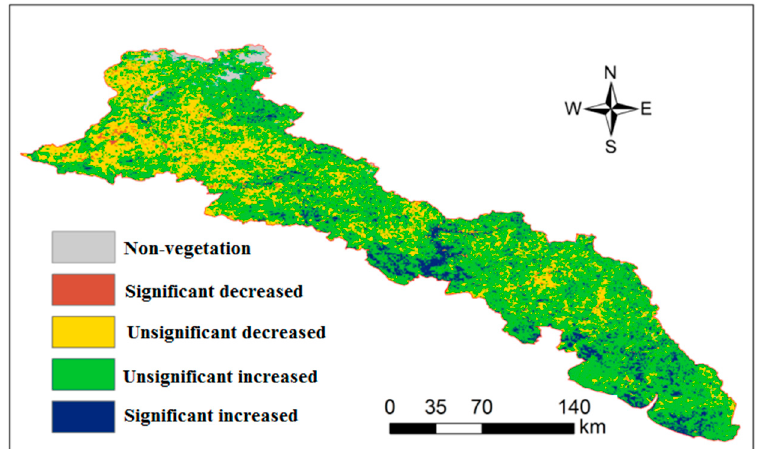
Figure 5. Significance of variation of GPP in the Altay Mountains.